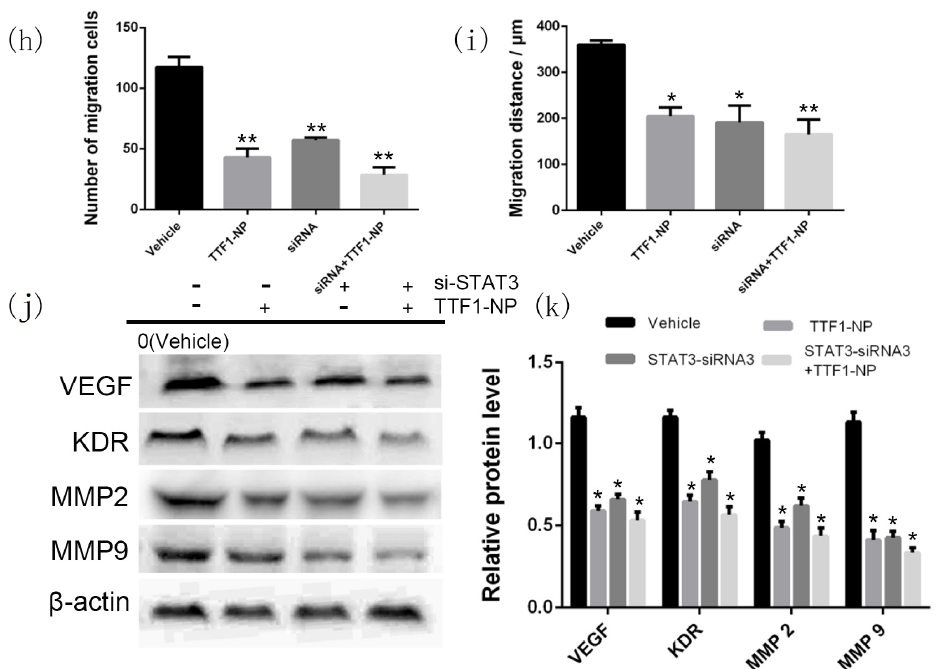
Figure 5. STAT3 plays a role in TTF1-NP inhibition of cell angiogenesis, migration and invasion. ( a ) Western blot analysis suppression of STAT3 and p-STAT3 protein in HepG2 cells knocked down for STAT3 by siRNA; ( b ) Western blot analysis STAT3 and p-STAT3 expression in cells transfected with STAT3–siRNA or negative control siRNA (NC) and treated with TTF1-NP as indicated; ( c , d ) Quantification of western blot data from ( a , b ), data represent mean ± SD of three independent experiments. * p < 0.05 and ** p < 0.01 for the designated treatment vs. Vehicle; ( e ) Tube formation assay with HepG2 and STAT3-siRNA HepG2 cells treated with TTF1-NP in 100 µ M (100 × magnification); ( f ) transwell assays with HepG2 and STAT3-siRNA HepG2 cells treated with TTF1-NP in 100 µ M (200 × magnification); ( g ) Scratch healing assay with HepG2 and STAT3-siRNA HepG2 cells treated with TTF1-NP in 100 µ M (100 × magnification); ( h ) Quantitative data of migrated cells in ( f ), represent the mean ± SD of three measurements, * p < 0.05 and ** p < 0.01 for the designated treatment vs. Vehicle; ( i ) Quantitative data of invasion cells in ( g ), represent the mean ± SD of three measurements, * p < 0.05 and ** p < 0.01 for the designated treatment vs. Vehicle; ( j ) Western blot analysis of VEGF, KDR, MMP2 and MMP9 expression in cells treated as indicated; ( k ) Quantification of western blot analysis normalized by the levels of β -actin. Data represent mean ± SD of three independent experiments. * p < 0.05 and ** p < 0.01 for the designated treatment vs.